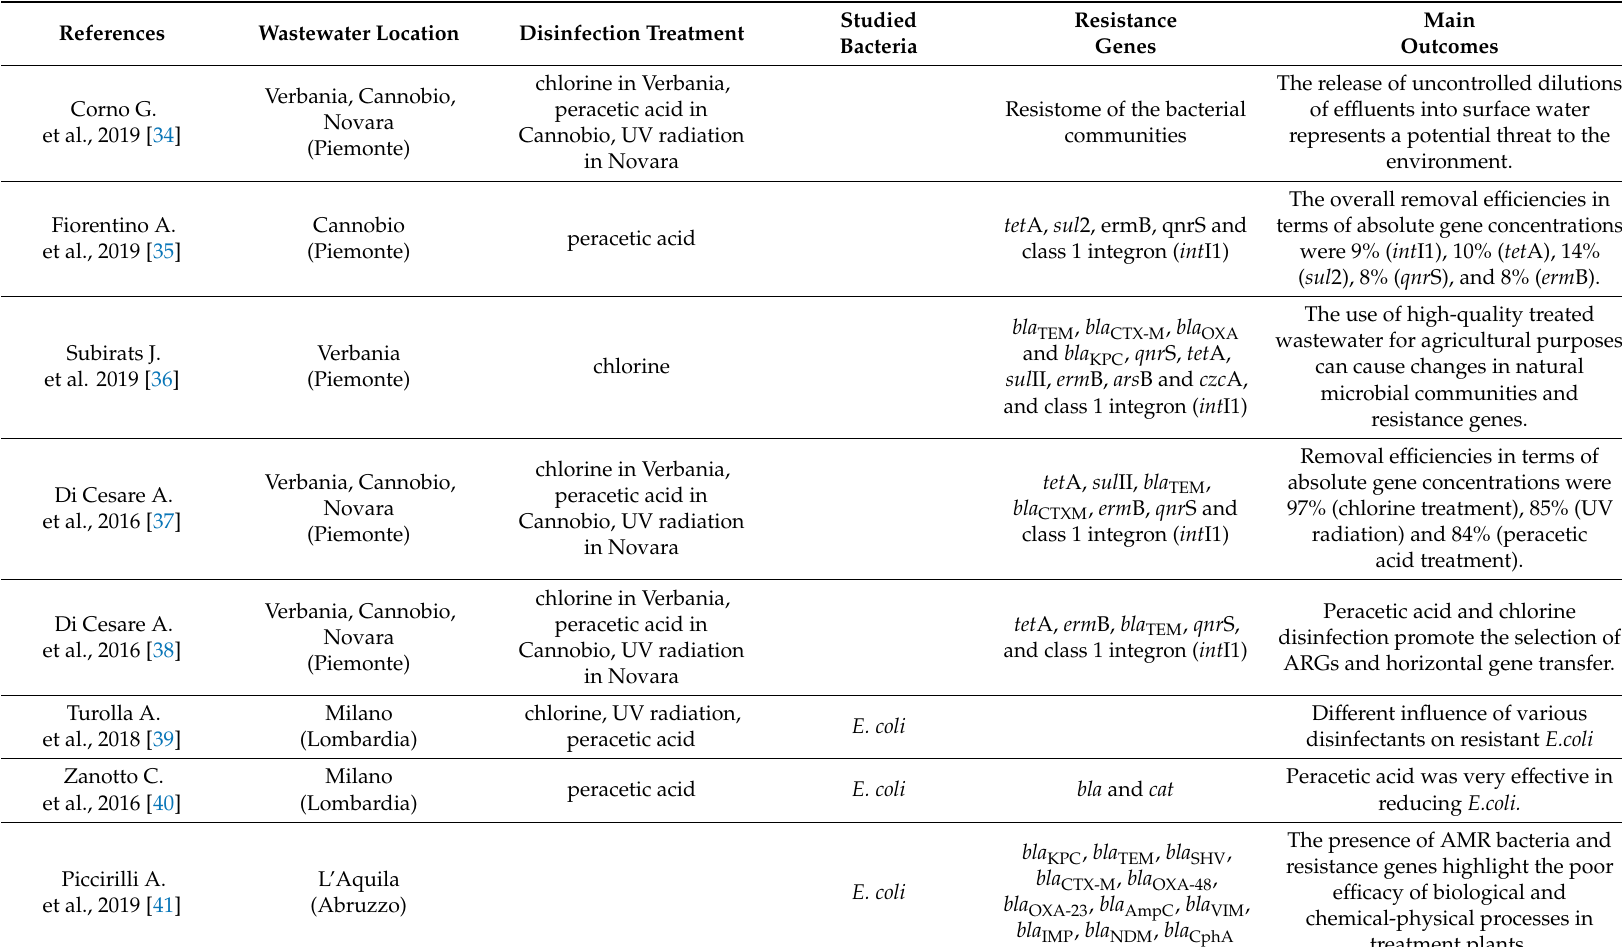
Table 1. Overview of antimicrobial resistance in wastewater in Italy, divided by geographical